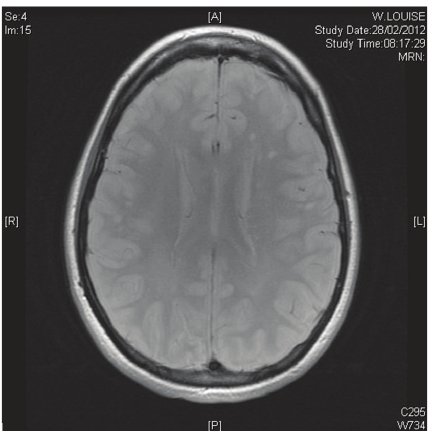
Figure 2: Axial view showing periventricular lesions supporting a clinical diagnosis of demyelination in the clinical context and knowledge of the spine.